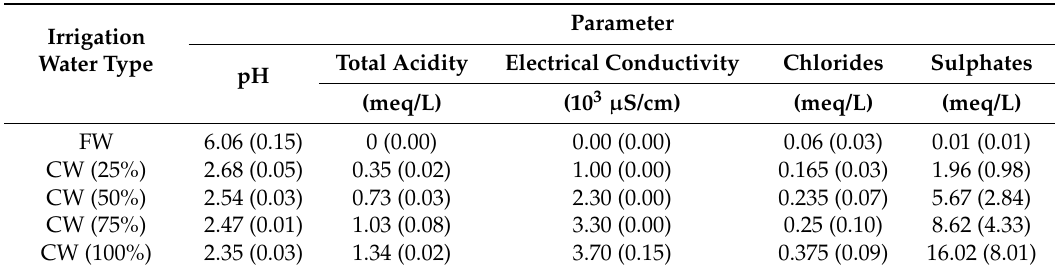
Table 1. Mean values for irrigation water chemical parameters. The numbers in parentheses are the standard error of the means of three replicates.